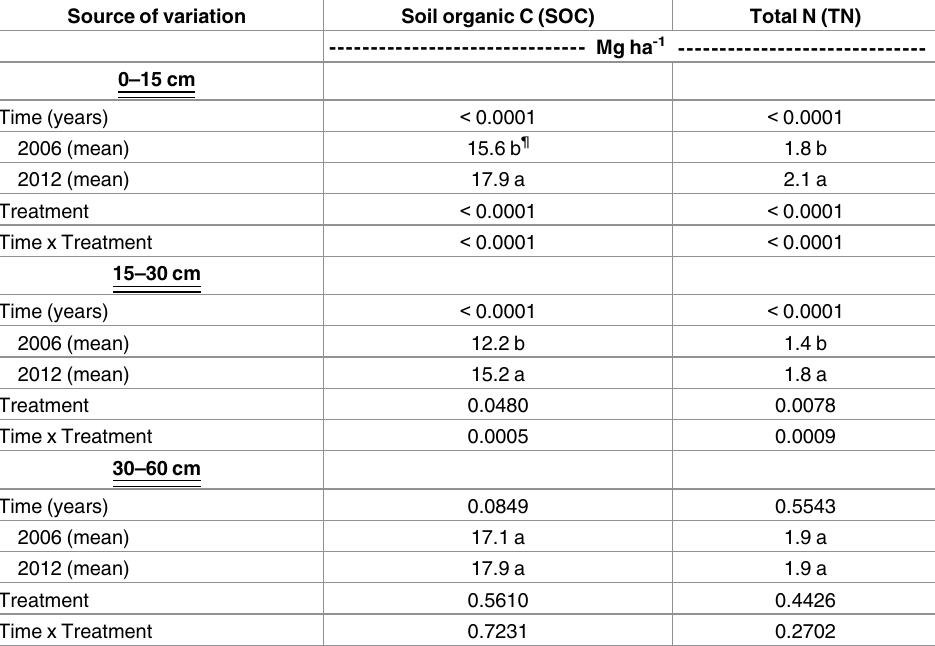
Table 9. Statistical significance of the main and interaction effects of different treatment combina- tions and sampling time (years) on soil organic C (SOC) and total N (TN) at 0–15, 15–30,and 30–60cm depth from 2006to 2012 sampling